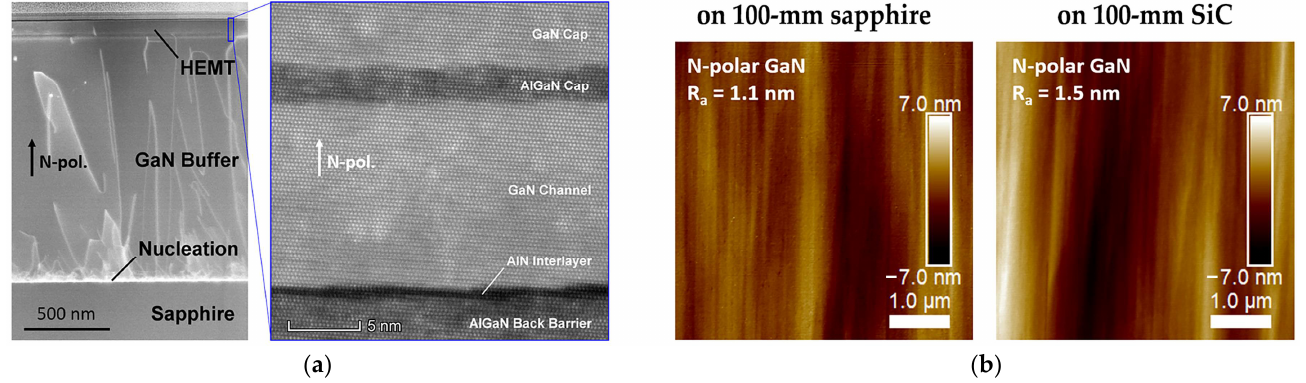
Figure 15. ( a ) STEM cross-section of the N-polar GaN epitaxy and NPDR MIS-HEMT layers; ( b ) AFM topography image of N-polar GaN epitaxy on 100 mm sapphire and 100 mm miscut C-face SiC substrates. Adapted with permission from Ref. [67]. Copyright 2021 by IEEE.